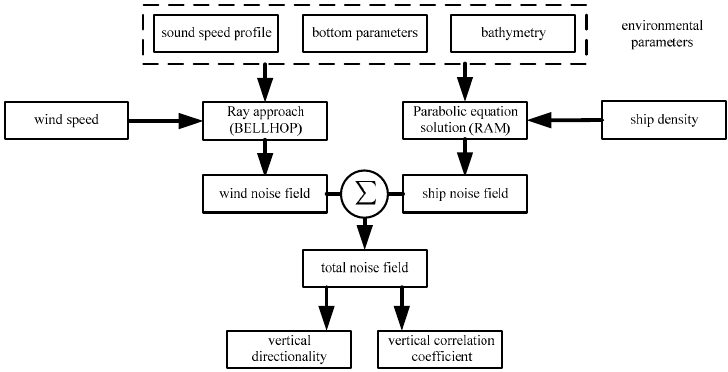
Figure 2. Flowchart of modeling the low-frequency ambient noise field.